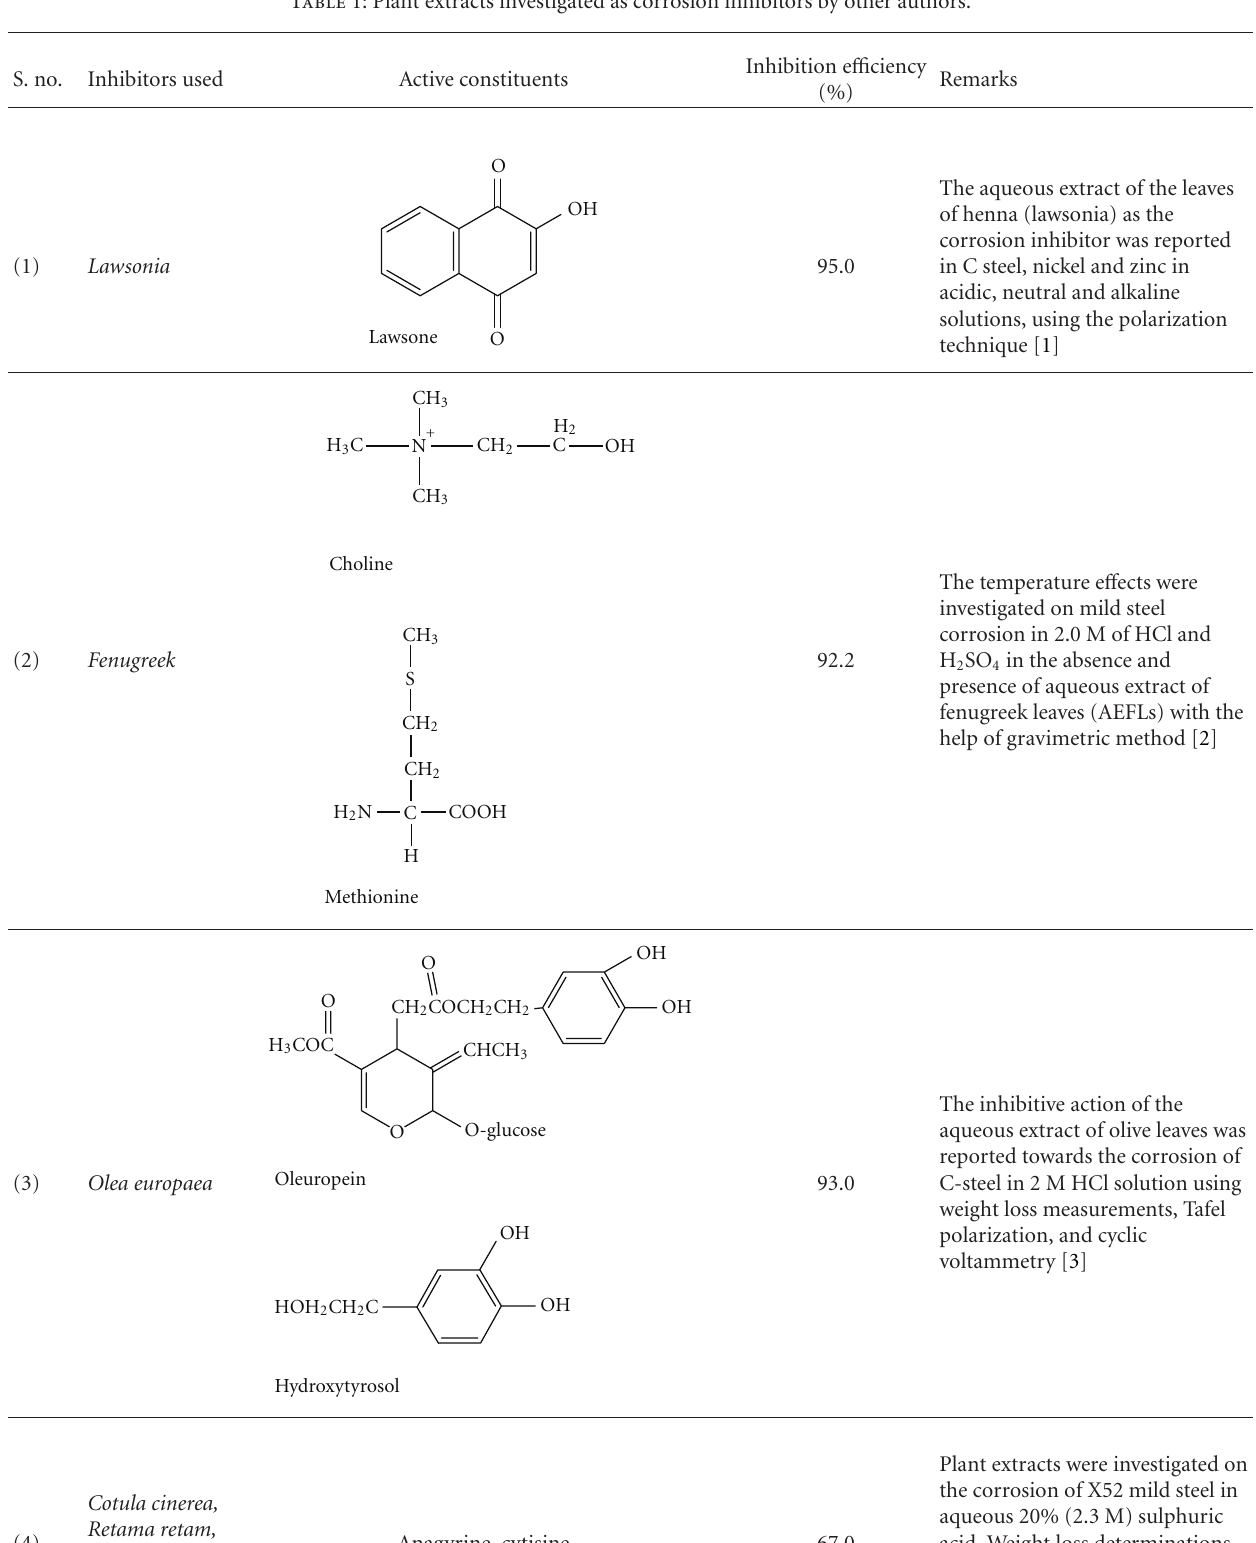
Table 1: Plant extracts investigated as corrosion inhibitors by other